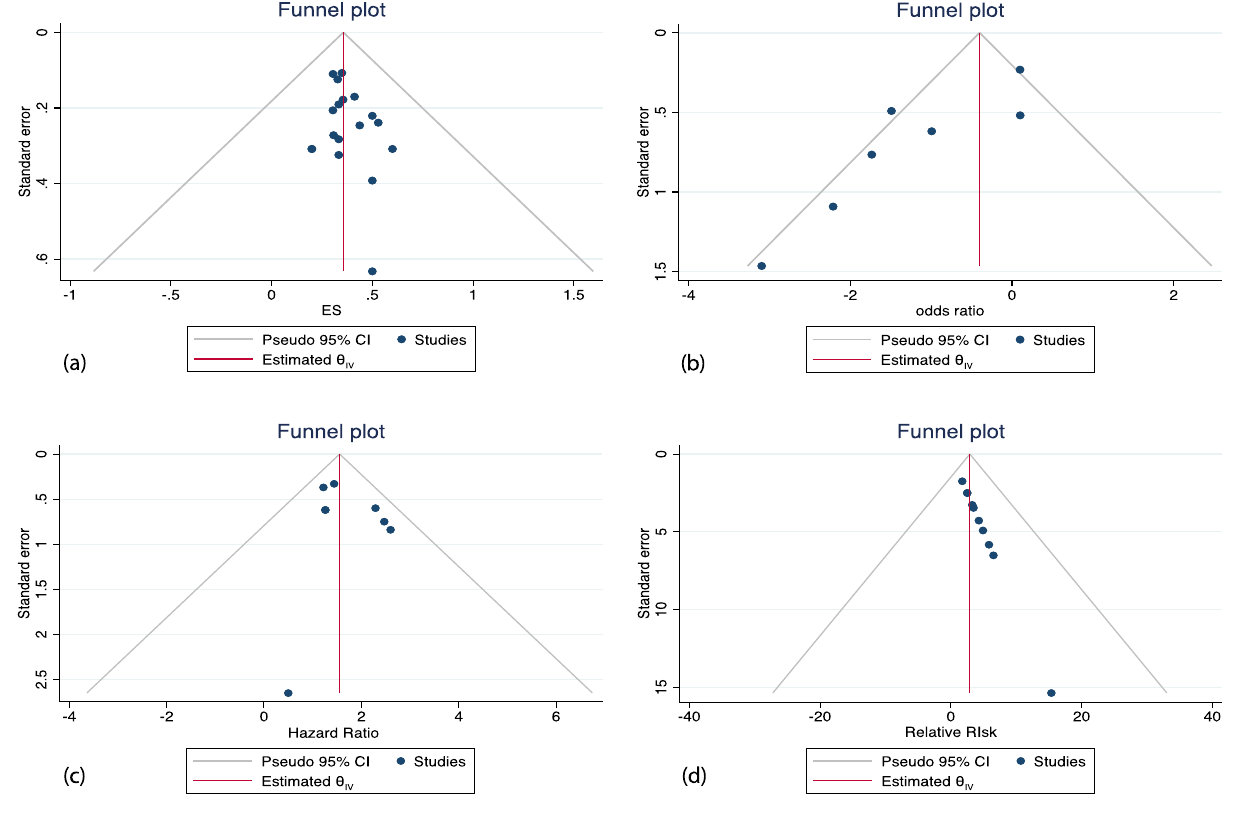
Figure 2. ( a ) Shows the funnel plot for case fatality rate. ( b ) Shows the funnel plot for excess mortality. ( c ) Shows the funnel plot for 30-day mortality. ( d ) Shows the funnel plot for excess [95% CI 35–73%]. Additionally, hypertension (60% [95% CI 0.25–0.91]), diabetes (57% [95% CI 0.37–0.76]) and dementia (29% [95% CI 0.11–0.49]) were the most frequently observed comorbidities in COVID-19 positive hip fracture deaths. The baseline characteristics and demographics of deceased patients are shown in Table 3. Mortality meta‑analyses. Excess mortality. All hip fracture patients during COVID-19 period vs pre-COVID-19 period. Eight studies 31–34,43–46 reported mortality during the pandemic compared to a pre- COVID-19 control group. A higher mortality was observed during the pandemic of all hip fracture patients (10% [95% CI 0.08–0.11]) in comparison to the control group 5% [95% CI 0.04–0.06]), p < 0.001. From the included studies pooled estimates obtained indicated an increased hip fracture mortality during the COVID- 19 pandemic, OR 2.00 [95% CI 1.02–3.94], p = 0.007, I 2 = 64.3%, as shown in Fig. 4a. All the studies reporting excess mortality were considered as moderate or good quality studies, and hence sensitivity analyses remained unchanged 31–34,43–46 . Non-positive COVID-19 patients during the pandemic vs pre-COVID-19 control. Seven studies 31–34,43,44,46 reported the number of non-COVID positive deaths during the pandemic period, which was meta-analysed against the mortality in the pre-COVID-19 control cohort. An odds ratio (OR) of 0.97 (95% CI 0.67–1.39), p = 0.08 was observed, as shown in Fig. 4b. All-cause mortality (All reported deaths of COVID-19 positive vs non-positive COVID-19 patients). Twelve studies 7,30–34,39–42,44,47 reported mortality in COVID-19 positive hip fracture patients against a non-positive COVID-19 cohort. Within this cohort, COVID-19 positive deaths were 47% (95% CI 0.40–0.53) whilst COVID- 19 non-positive deaths were 53% (95% CI 0.46–0.59). A relative risk (RR) of 4.59 [95% CI 3.61–5.85], p < 0.0001, [I 2 7.4%, p = 0.373], Z = 12.39 showed increased risk of hip fracture mortality due to COVID-19 infection, as shown in Fig. 5a. Greatest risk ratio was seen in studies from the USA, RR 6.51 (95% CI 3.26–13.01), p < 0.0001). Pooled estimates for UK-based studies was RR 4.19 (95% CI 3.20–5.47), p < 0.0001. All-cause mortality within the Spanish studies was similarly found to be RR = 4.06 (95% CI 1.60–10.37), p = 0.003, and a single study from Italy was RR = 14 (95% CI 1.95–100.26), p = 0.009. Sensitivity analysis assessing all-cause mortality remained unchanged as all studies were of moderate or good quality 28–37,39,39–45,47 .